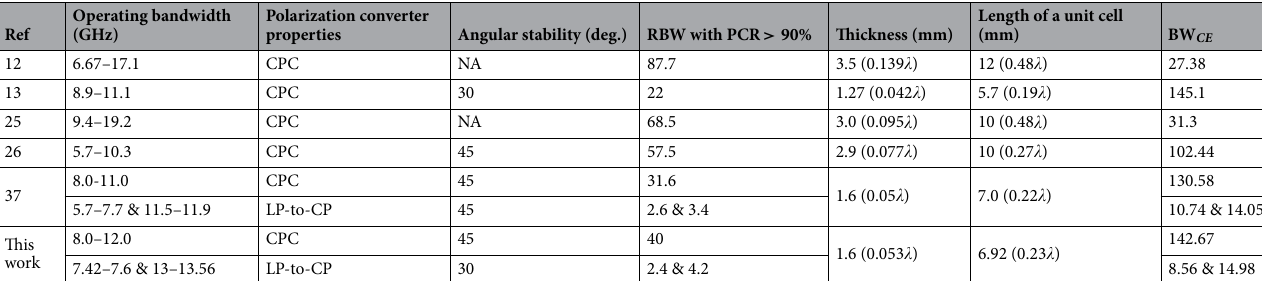
Table 1. Comparison the performance of the proposed polarization converter with other broadband polarization converter.